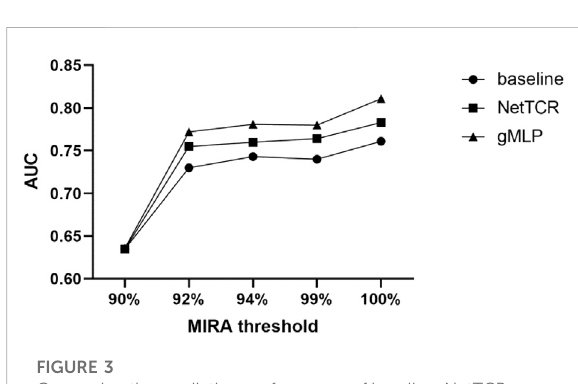
FIGURE 2 Prediction performance of NetTCR, baseline, and gMLP models are compared using AUC in the IEDB dataset with four different thresholds of 90%, 92%, 94%, and 99% similarity, respectively.